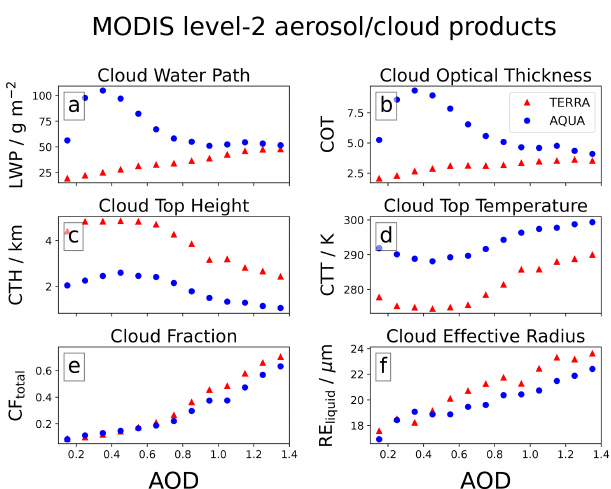
Figure 16. Cloud properties from the MODIS 5km cloud product binned by MODIS 10km AOD for the TERRA (red triangles) and AQUA (blue circles) satellite overpasses. The mean values (sym- bols) are taken from all spatially and temporally collocated grid points within the AOD bin (5km product regridded to 10km). Data are for September 2002 to 2019 inside the domain 9 to 1 ◦ S, 68 to 58 ◦